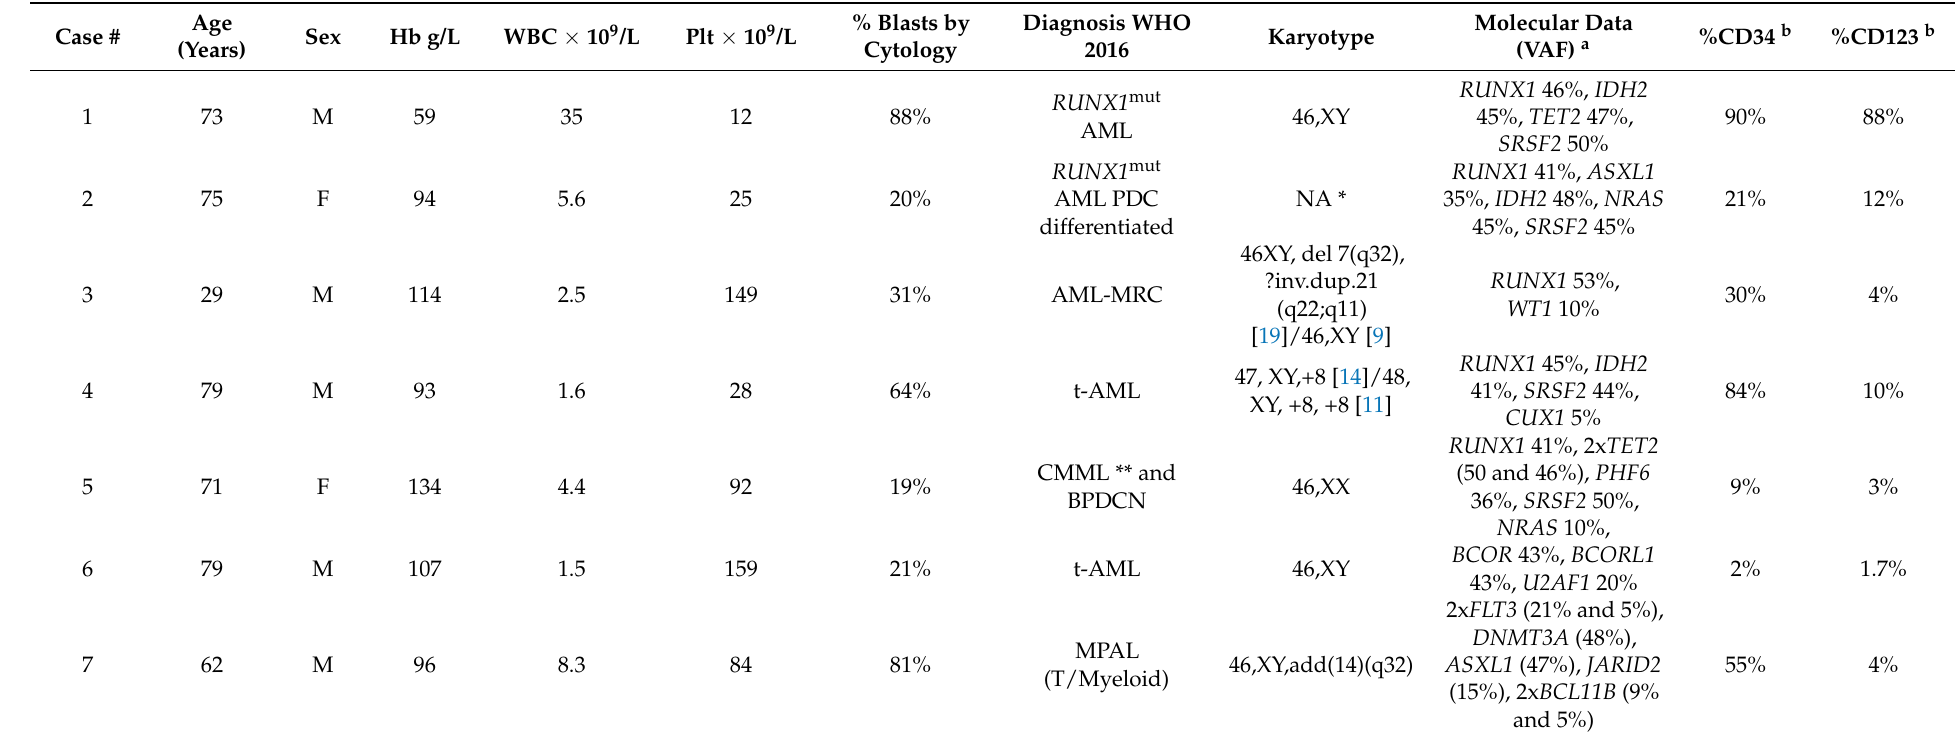
Table 1. Patient